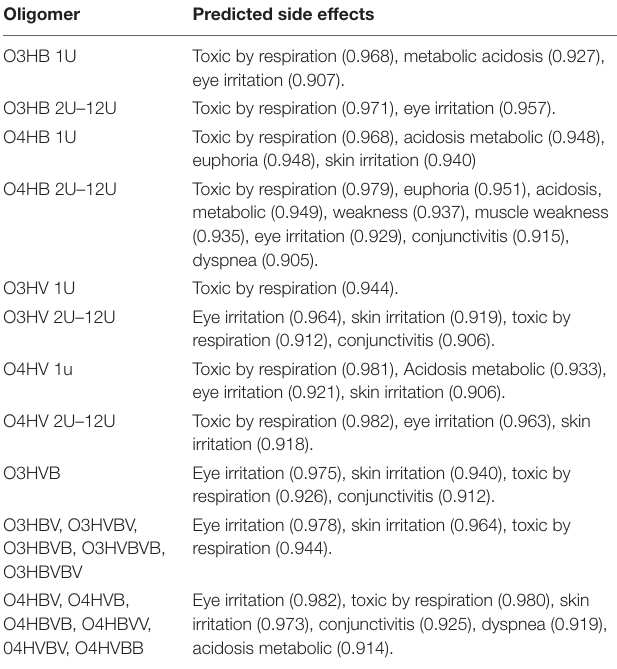
TABLE 6 | Predicted side effects of the low molecular weight OHAs using PASS software. Oligomer Predicted side